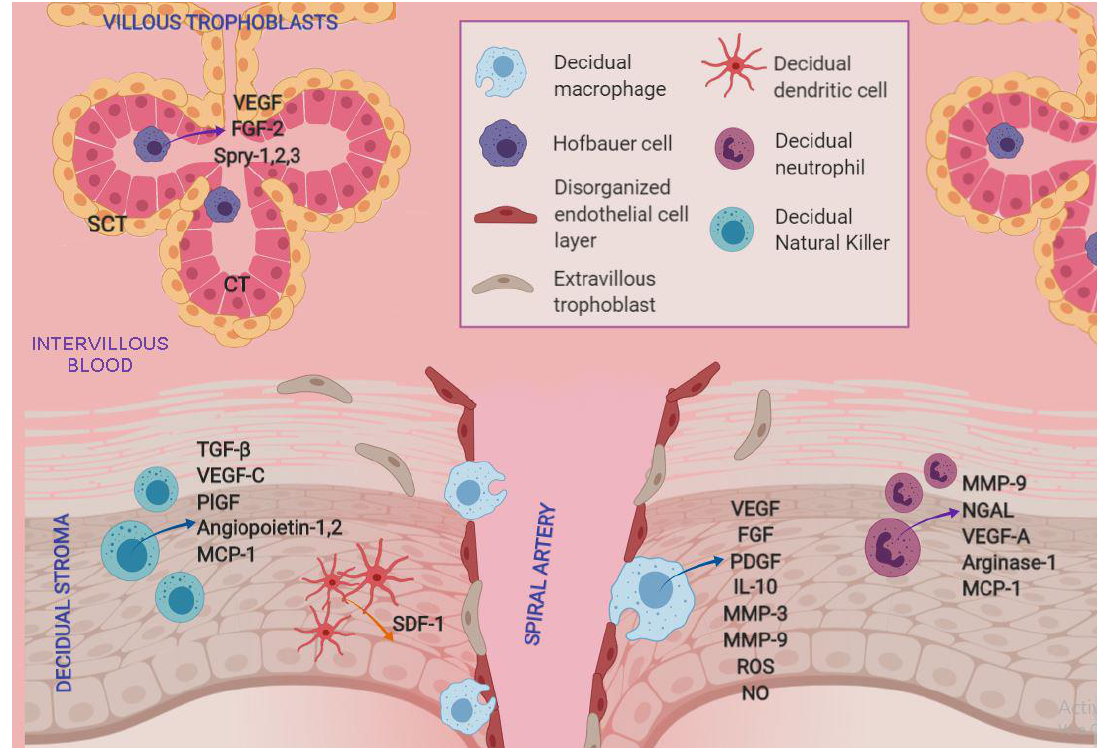
Figure 3. Pro-angiogenic network mediated by innate immune cells at the maternal–fetal interface. Angiogenic molecules secreted by macrophages, dendritic cells, natural killers and neutrophils in the decidua contribute to spiral artery remodeling and the replacement of endothelial cells with extravillous trophoblasts during trophoblast migration. Hofbauer cells immersed in villous mesenchyme produce VEGF, FGF-2, Spry-1, Spy-2 and Spry-3 to regulate fetal capillary growth, proliferation and branching. SCT = syncytiotrophoblasts; CT = citotrophoblasts.